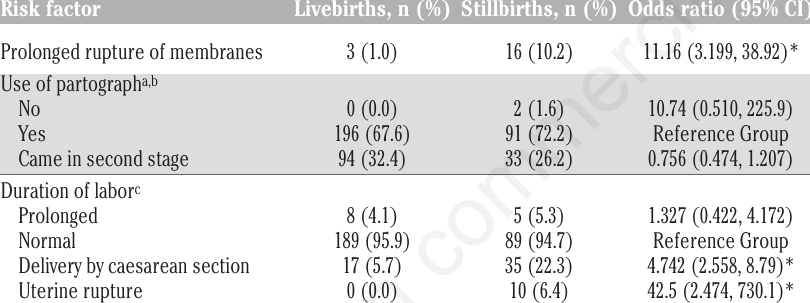
Table 3. Intra-partum determinants of